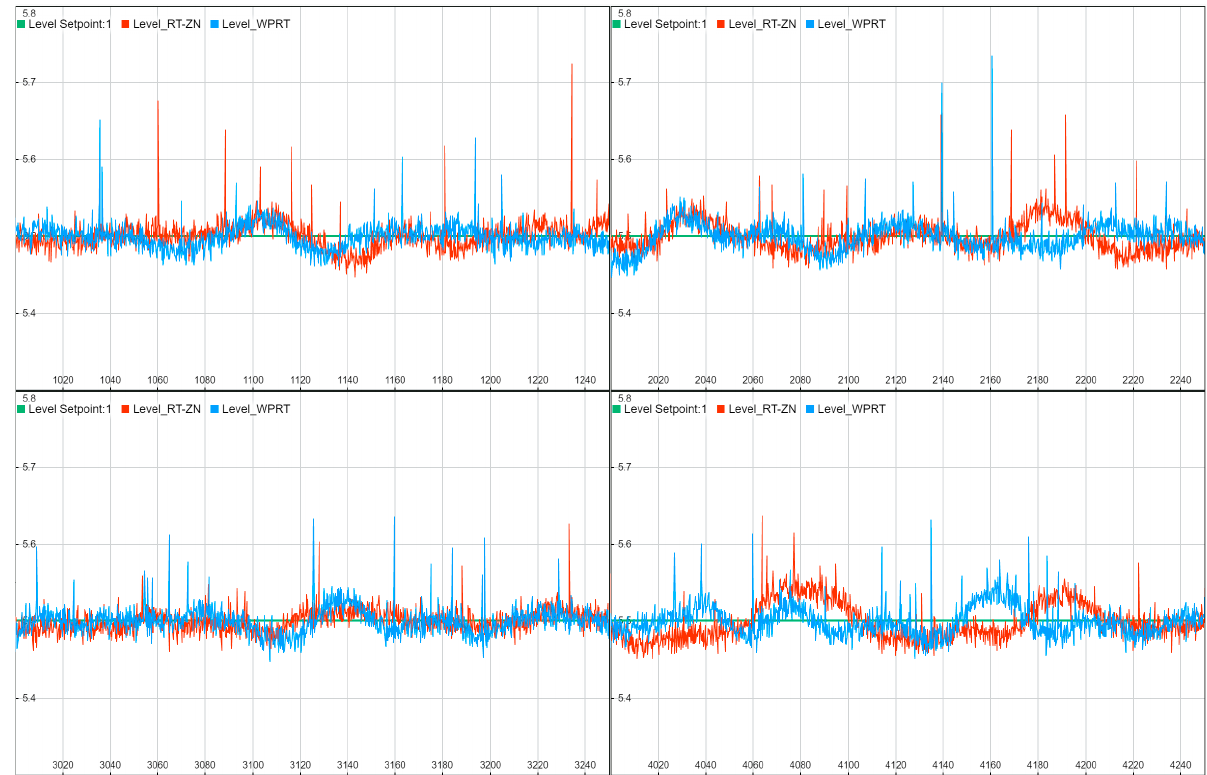
Figure 13. Controller nominal operation test: In the nominal operation mode, the deviation was recorded to compare the two tunings of the controller. Water-level setpoint (green), RT-ZN tuning (red), proposed WPRT method (blue).